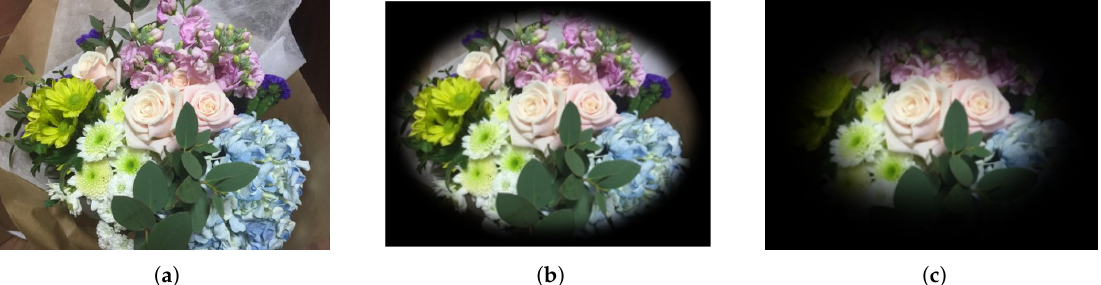
Figure 1. Progressive visual loss caused by glaucoma. ( a ) Normal vision. ( b ) As glaucoma advances, the field of vision of a patient slowly narrows. ( c ) Advanced glaucoma without proper treatment leads to substantial vision loss, and to blindness if left